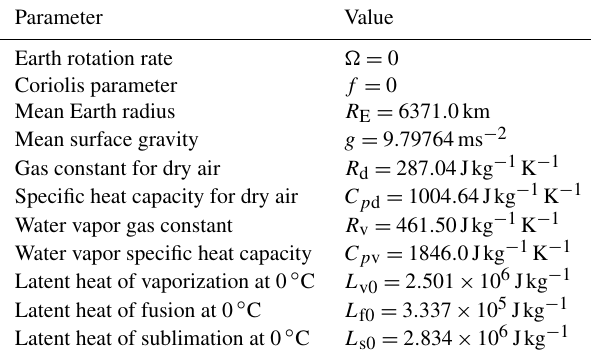
Table 1. Geophysical